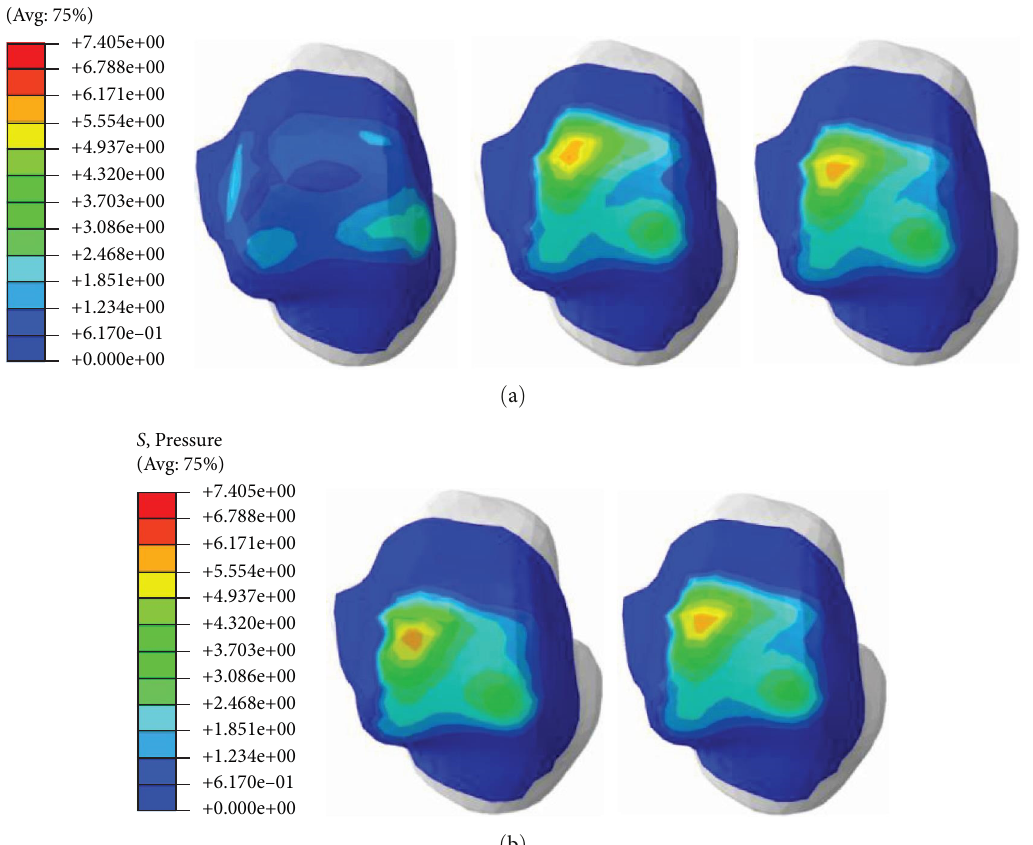
F IGURE 10: Contact pressure distribution of talocrural joint cartilage (a) at t 1 , t 2 , and t 3 gait instants in RFS jogging (from left to right) and (b) at t 2 and t 3 gait instants in FFS jogging (from left to right).